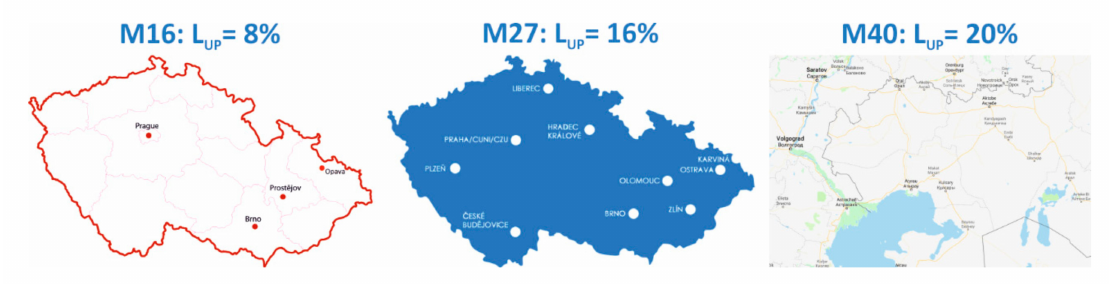
Figure 5. Maps with the lowest L UP values also marked by respondents as subloaded in L SE (two simple maps of Czechia and cutout of Google maps focused on the south part of Kazakhstan).